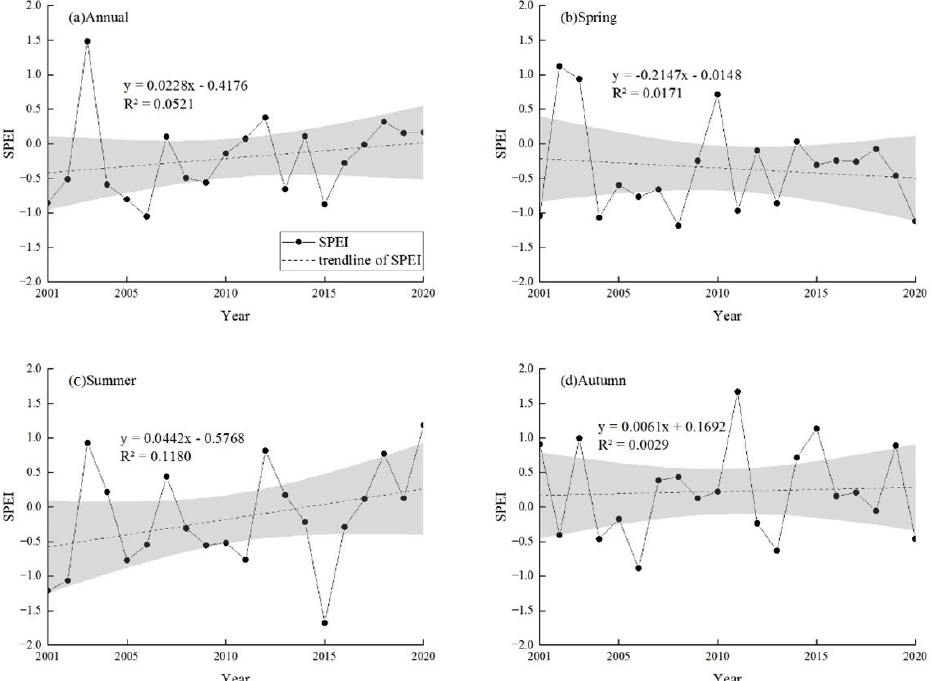
Figure 4. Interannual variation of SPEI in YRB 2001 to 2020 ( a – d ). ( a ) Annual, ( b ) spring, ( c ) summer, and ( d ) autumn.